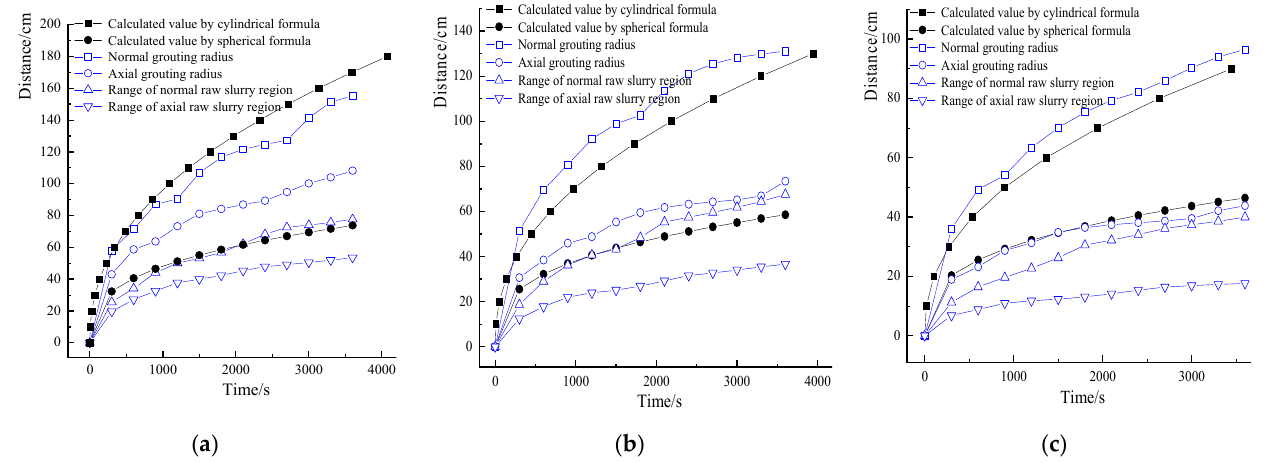
Figure 7. Comparison between numerically simulated values and theoretically calculated values of grouting radius at distinct grouting pressures; ( a ) 2MPa; ( b ) 1MPa; ( c ) 0.5MPa.